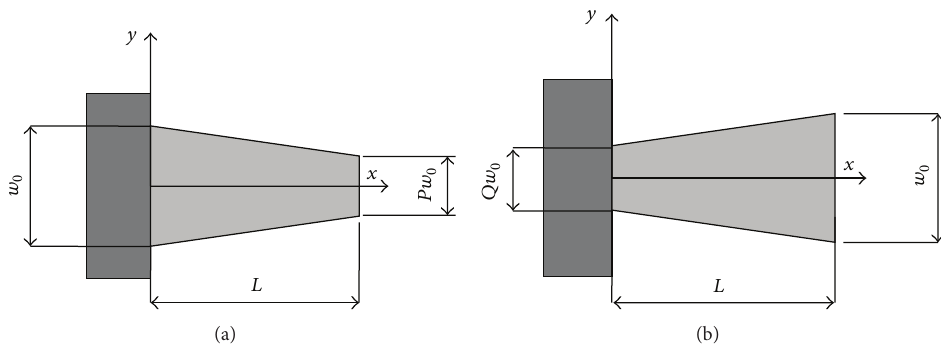
Figure 5: Standard shape modification of a bimorph piezoelectric harvester by parameters 𝑃 and 𝑄 .